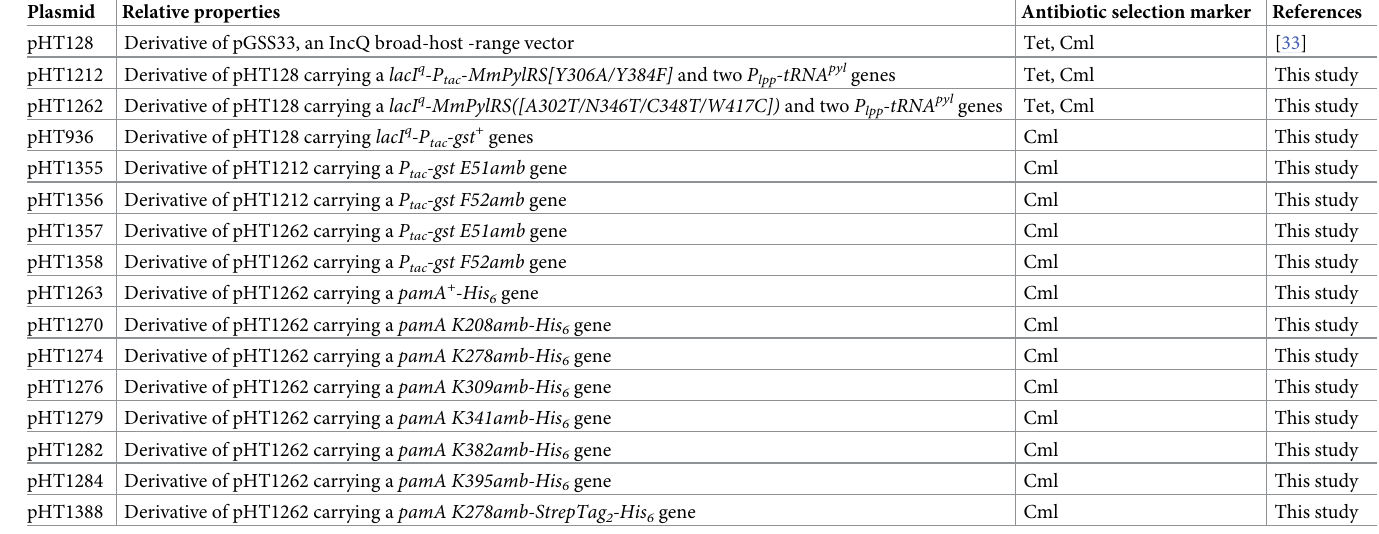
Table 1. IncQ plasmids introduced into N . meningitidis strains which results were shown in this study.